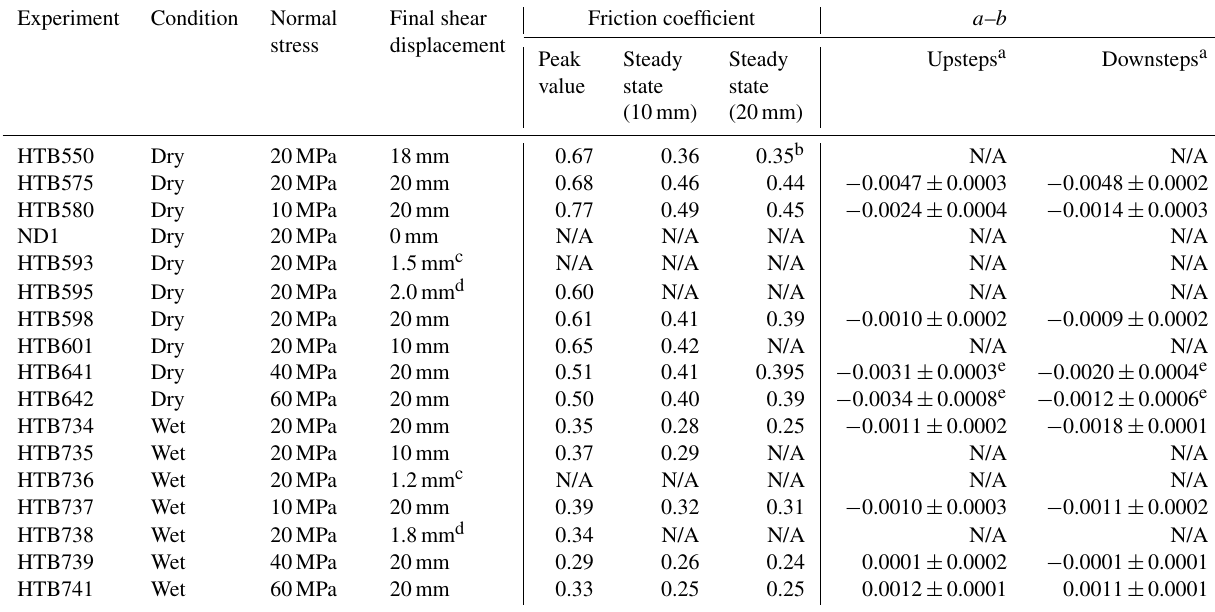
Table 1. Summary of the experimental conditions and results.